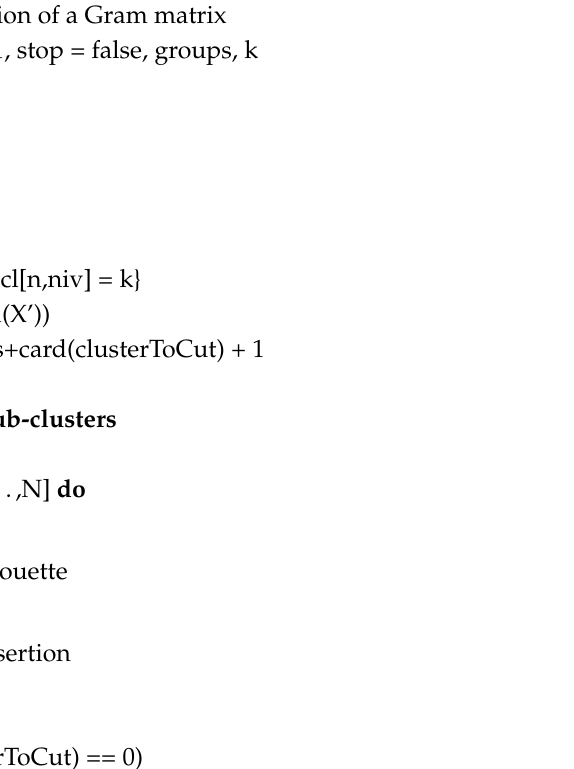
Figure 1. Multi-level Spectral Clustering (M-SC) extended with no-cut criteria scheme. Algorithm 1 Multi-Level Spectral Clustering with no-cut stop